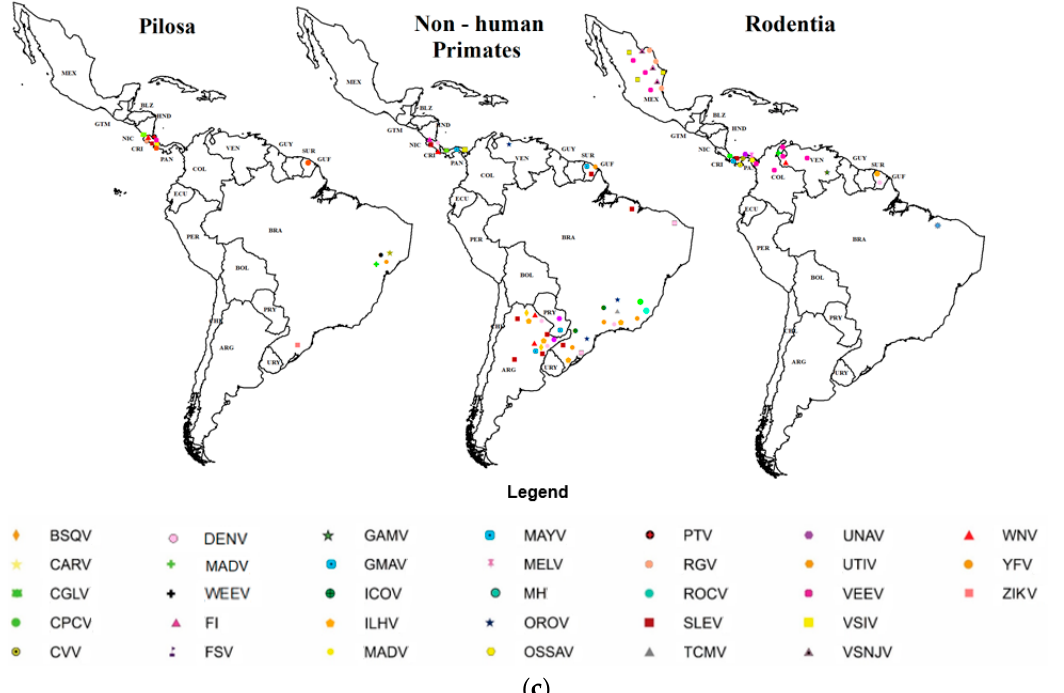
Figure 6. ( a ) Geographical location of arboviruses recorded by mammalian order in the Neotropics. ( b ) Geographical location of arboviruses recorded by mammalian order in the Neotropics. ( c ) Geographical location of arboviruses recorded by mammalian order in the Neotropics. Note: The concordance between the abbreviation of viruses and their full names is derivated from Table 1.